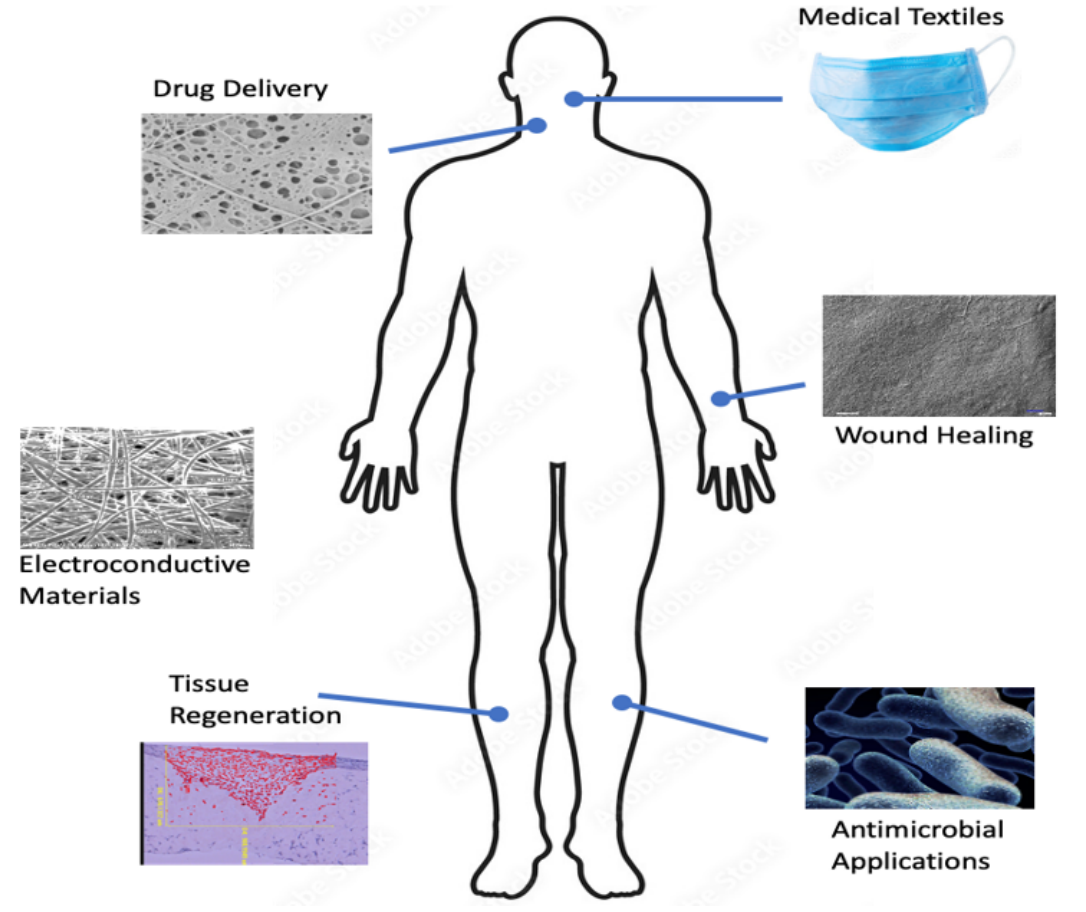
Figure 3. Applications of blow-spun fibers include medical textiles, drug delivery, wound healing, and tissue regeneration .